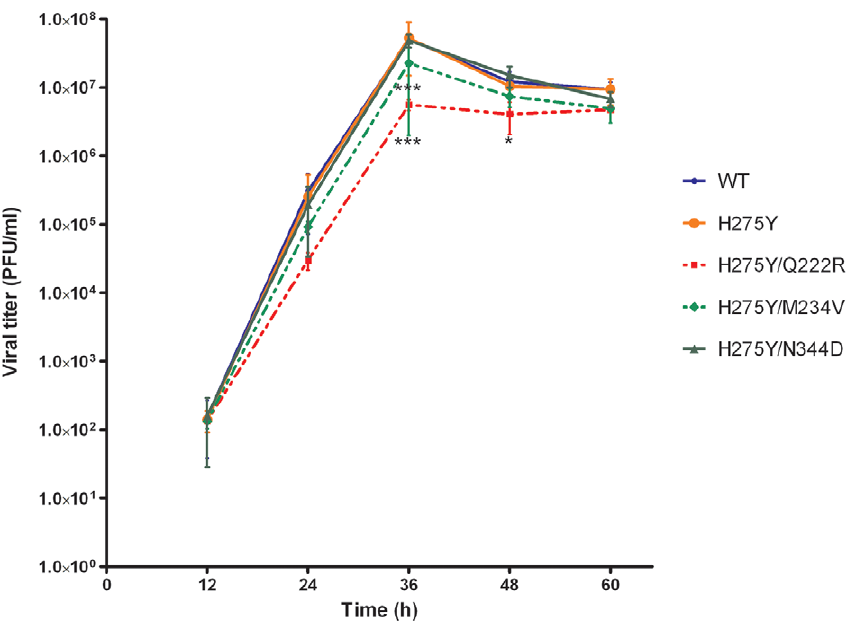
Figure 3. Replication kinetics of recombinant A/Brisbane/59/2007-like viruses invitro . Confluent ST6Gal1-MDCK cells were infected with recombinant viruses at a multiplicity of infection (MOI) of 0.001 PFU/cell. Supernatants were harvested at 12 h, 24 h, 36 h, 48 h and 60 h post- infection and titrated by standard plaque assays. The mean values for three experiments with standard deviations are presented. * P , 0.05 and *** P , 0.001 for differences in viral titers when compared to the recombinant WT virus.